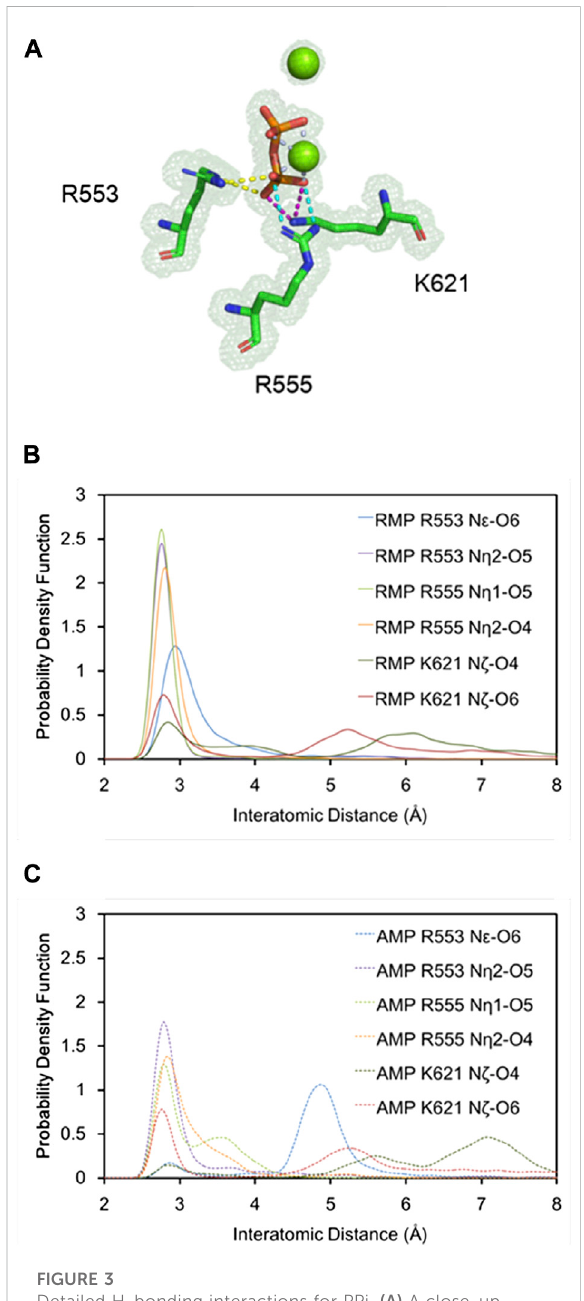
Detailed H-bonding interactions for PPi. (A) A close-up view of the MD-derived ED maps for PPi and interacting residues. (B,C) PDFs of the H-bond distance distribution for PPi and interacting residues with RMP ( B , solid curves) and AMP ( C , dashed curves) at position i +